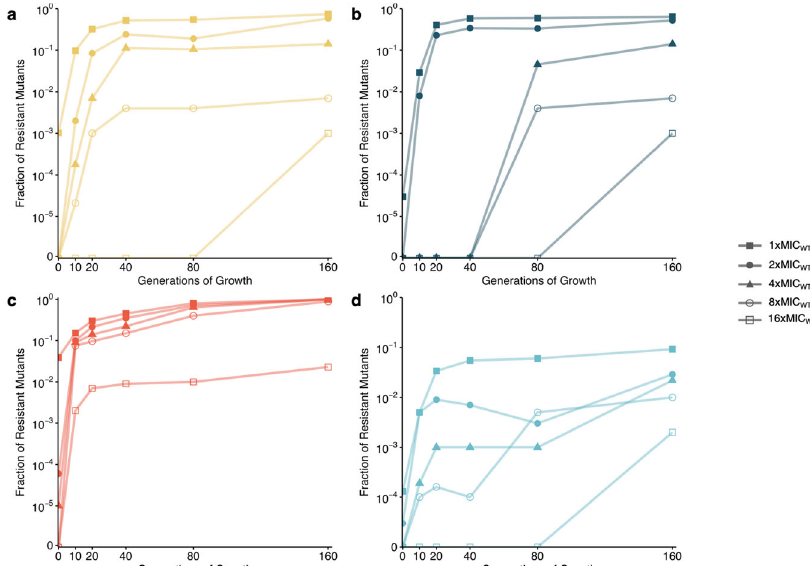
Fig. 2 Fraction of resistant mutants of the subpopulations selected at 1x the MIC of the parental susceptible strain. Subpopulations evolved from a E. coli DA33135 resistant to tobramycin, b S . Typhimurium DA34827 resistant to tetracycline, c S . Typhimurium DA34833 resistant to cefepime, and d E. coli DA61218 resistant to piperacillin-tazobactam. One serially passaged lineage per antibiotic was plated on Mueller-Hinton agar containing antibiotic at concentrations of 1x MIC WT (full squares), 2x MIC WT (full circles), 4xMIC WT (full triangles), 8x MIC WT (circles), and 16x MIC WT (squares) and the fractions of resistant mutants were calculated. Determination of fraction of resistant mutants was based on 1 biological and 1 technical replicates ( n = 1).